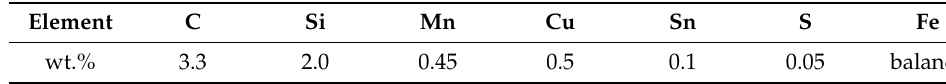
Table 2. Composition of the grey cast iron.